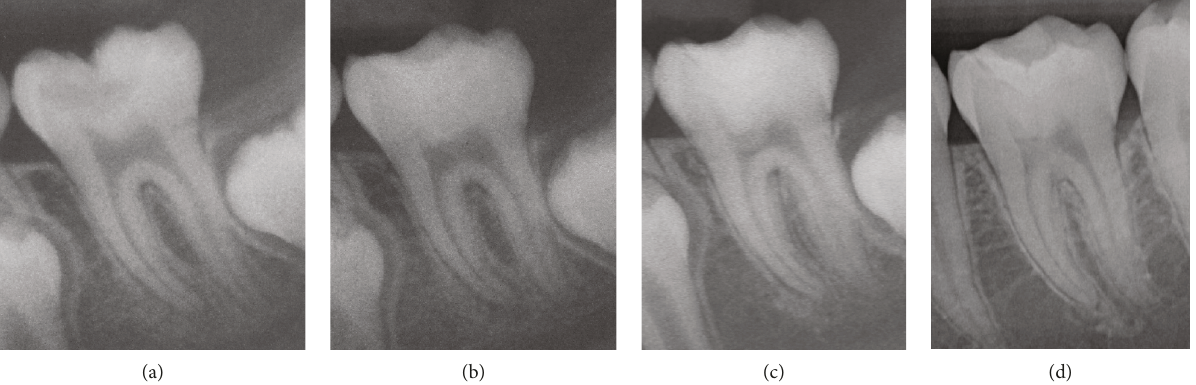
Figure 2: Periapical radiographs recorded (a) before treatment, (b) immediately after treatment, (c) six months postoperative, and (d) fi ve years postoperative, showing dentine bridge and improvement of the periapical